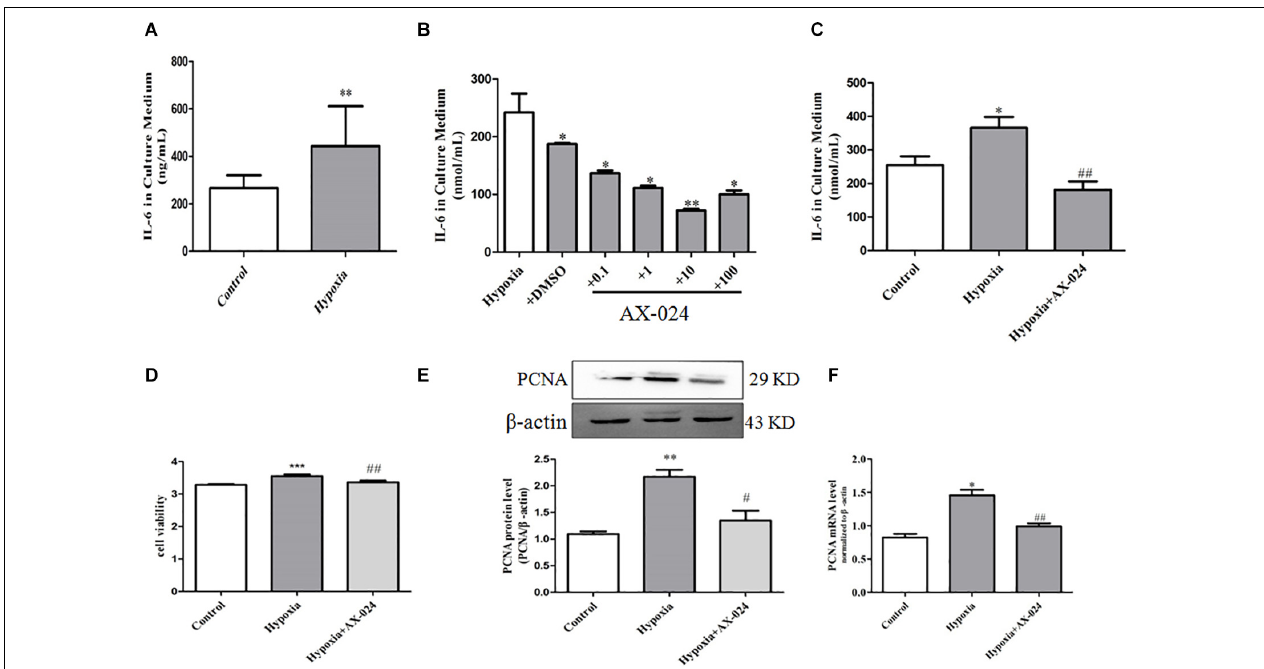
FIGURE 3 | Senescent PASMCs promote PASMC proliferation by paracrine IL-6 and AX-024 of IL-6 inhibitor can inhibit cell proliferation by inhibiting paracrine IL-6 in hypoxia-treated PASMCs. (A) The paracrine level of IL-6 in the supernatant in PASMCs by ELISA kit. (B) The level of IL-6 in the culture medium of hypoxia-induced PASMC proliferation by different concentrations of AX-024. (C) The level of IL-6 in the culture medium in different groups in PASMCs after AX-024 treatment, Proliferation of PASMCs was measured by CCK8 assay after incubation with different AX-024 (0.01, 0.1, 1, 10, 100, 1,000 nmol/mL). (D) The cell viability detection in PASMCs by CCK8 after treating with different concentration of AX-024. (E) The protein expression of PCNA was measured by Western blot. (F) The mRNA expression of PCNA was measured by qPCR. Data are mean ± SEM, n = 3. ∗ P < 0.05, ∗∗ P < 0.01 vs. control, ∗∗∗ P < 0.001 vs. control, # P < 0.05 vs. hypoxia, ## P < 0.01 vs. hypoxia; NS indicates no